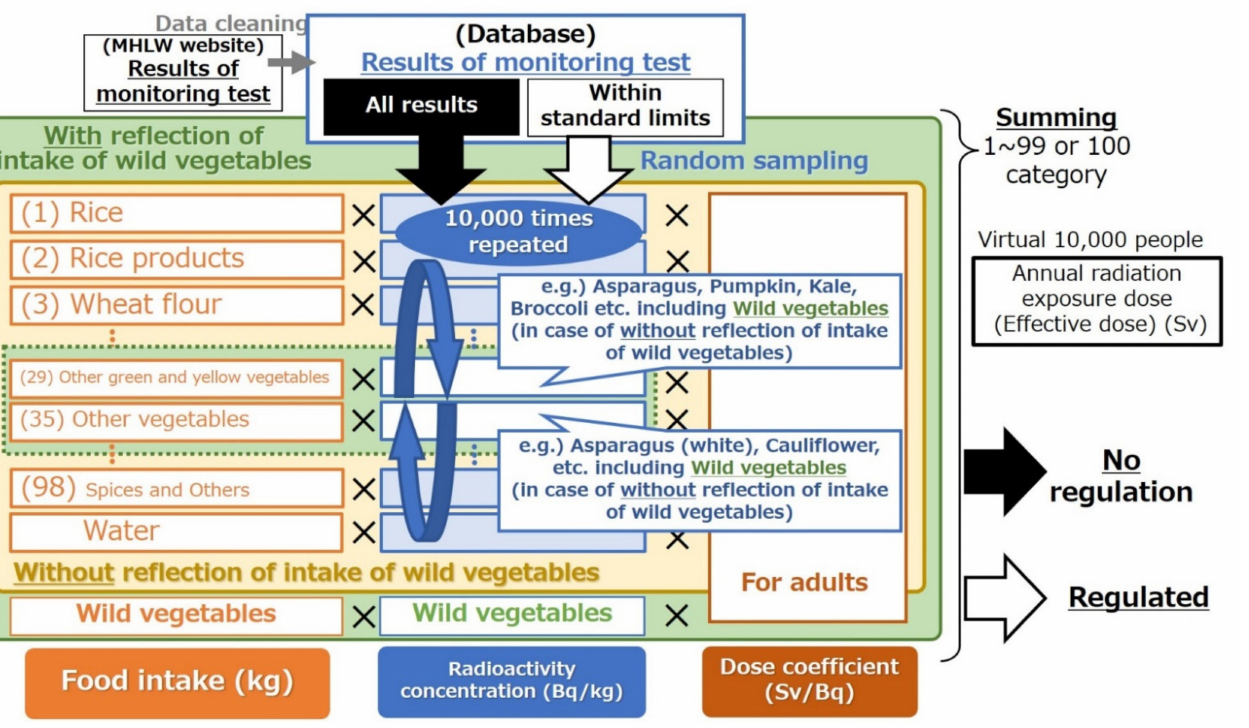
Figure 1. Schematic of data acquisition and dose calculation. Random sampling was individually repeated for the monitoring test results within the standard limits or for all results. The radiation exposure dose of virtual 10,000 persons was calculated as the multiplication product of the food intake in each food category, sampled radioactivity concentration, and dose coefficient. In radiation dose estimation without the reflection of intake of wild vegetables, wild vegetables were considered as “other green and yellow vegetables” or/and “other vegetables”. The number in parentheses denotes a small classification number in